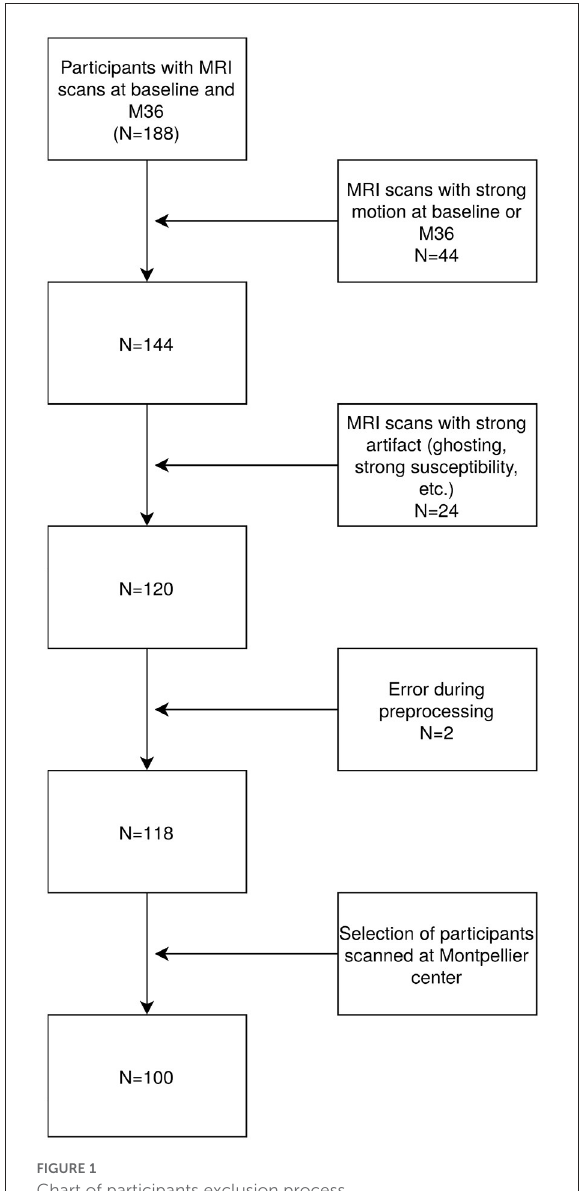
FIGURE1 Chart of participants exclusion process.